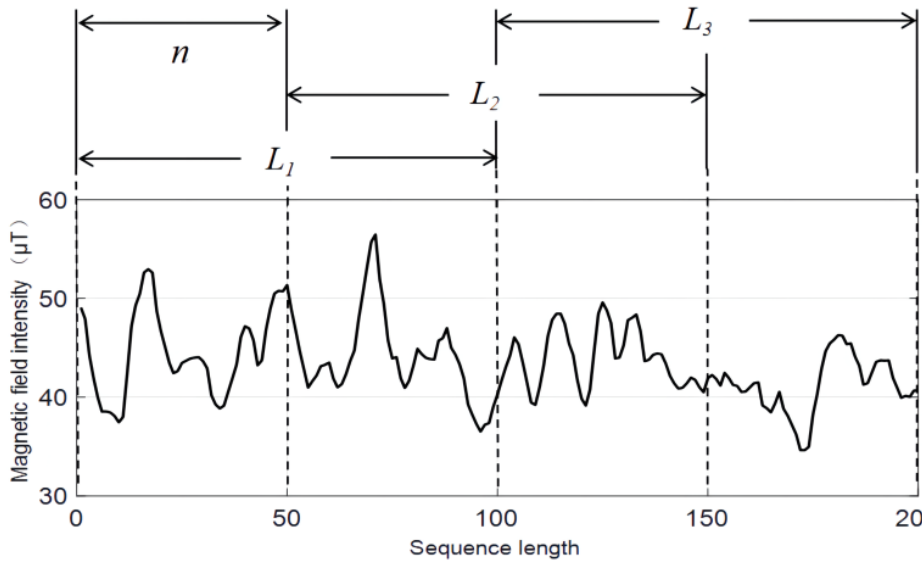
Figure 6. Acquisition of magnetic sequence set.